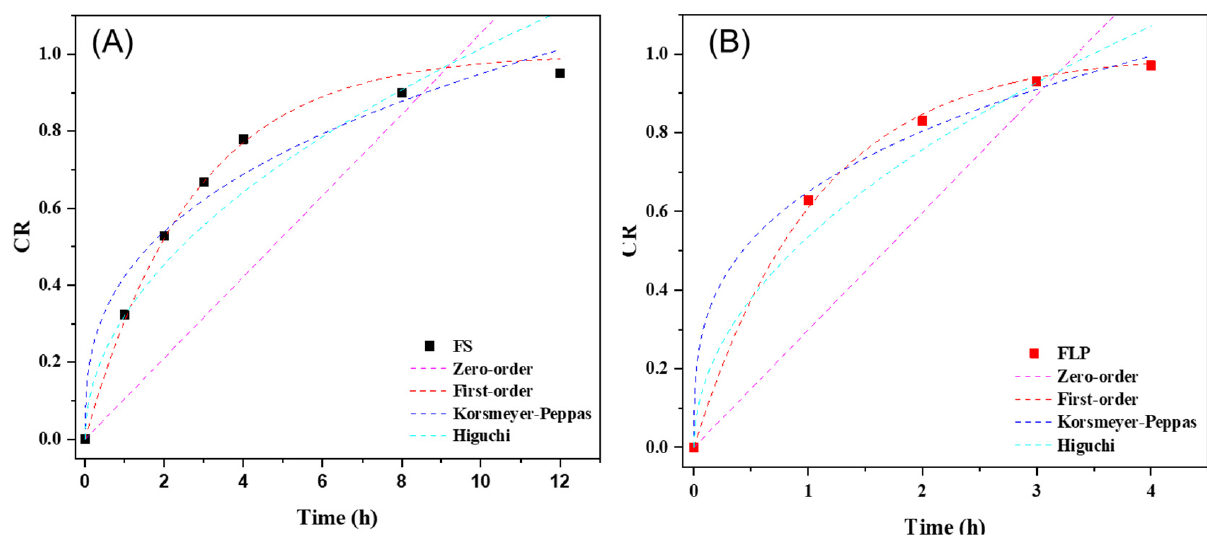
Figure 7. The kinetics release of FS ( A ) and FLP ( B ) .